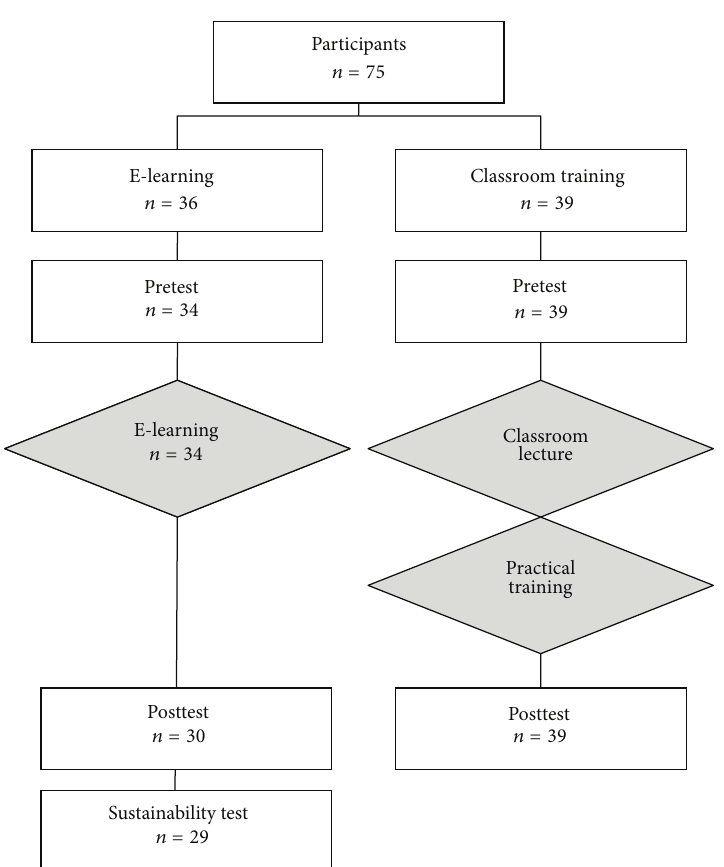
Figure 1: Flow diagram of all study participants. The classroom training cohort was part of the THOLUUSE study (with permission [14]).